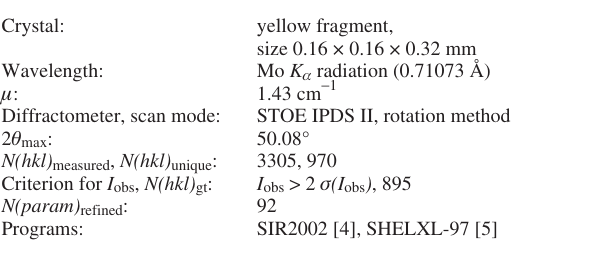
Table 1. Data collection and